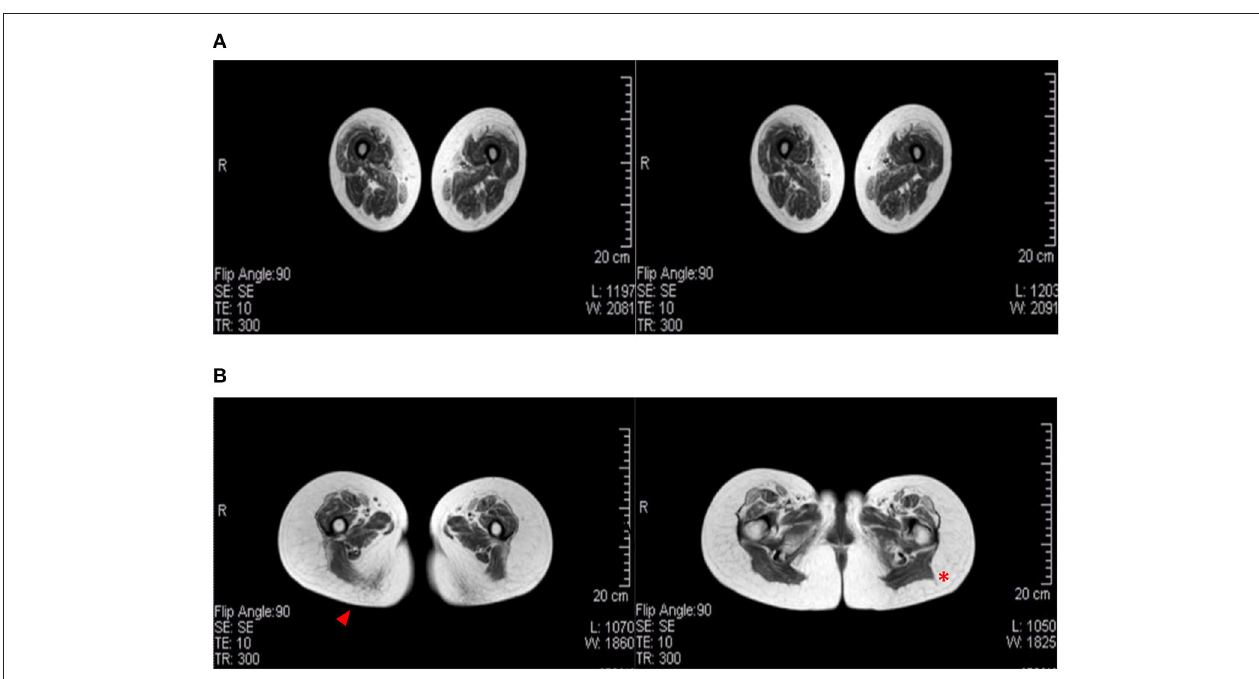
FIGURE 2 | Muscular MRI radiological aspects. (A) A female patient (age 60) affected by LGMD D2 and mother of (B) the index female case of the Italian branch of the Italo-Spanish family (age 34). Advanced replacement and atrophy of the semitendinous (arrowhead) compared to the back muscles of the thigh of the wide side and the femoral rectus of the middle and small gluteus (red asterisk) to the illicit